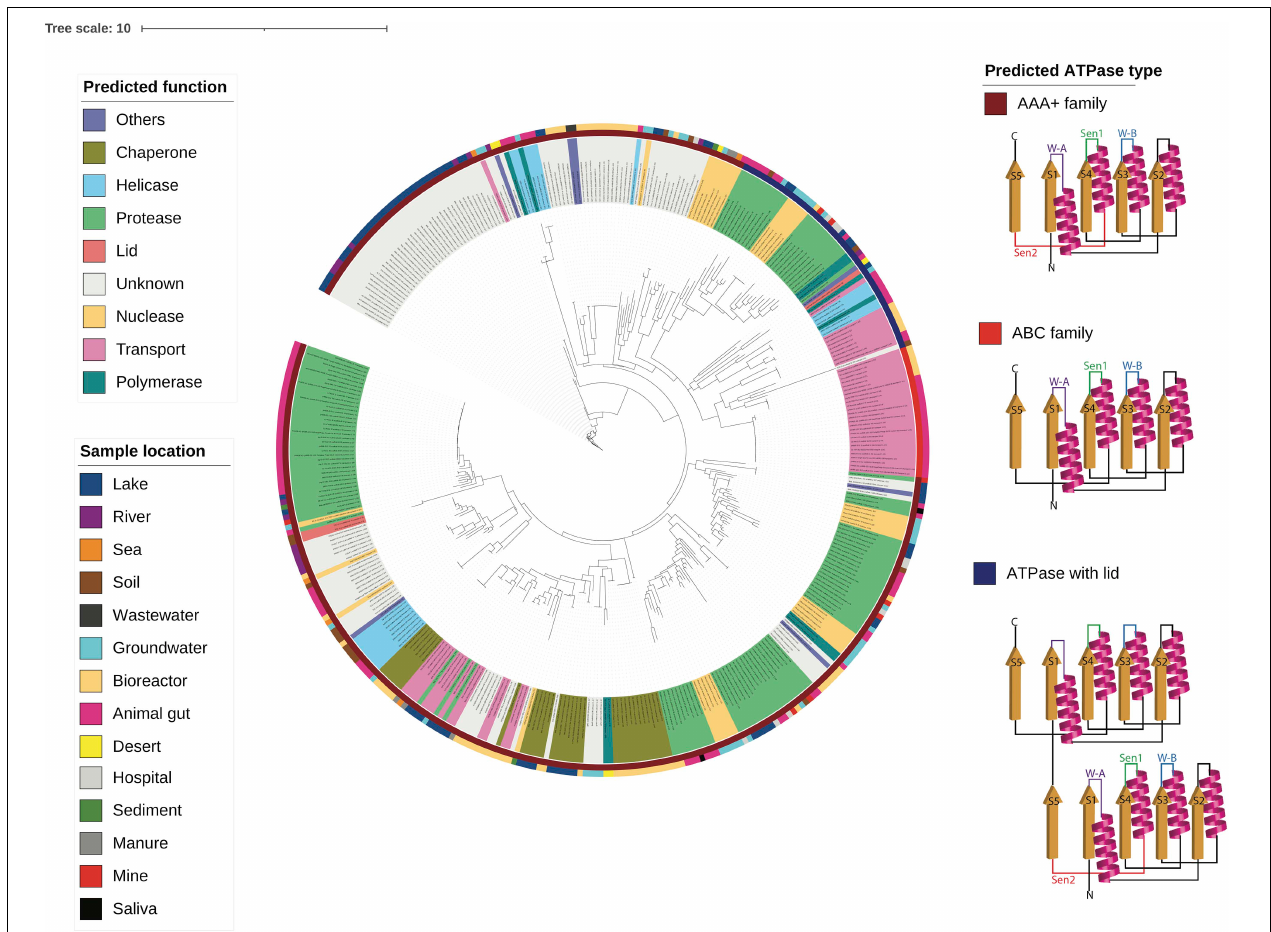
FIGURE 4 | A phylogenetic tree of the ATPase domains from diverse environments is built using the multiple sequence alignment and the structural reconstruction is shown for each class of ATPase